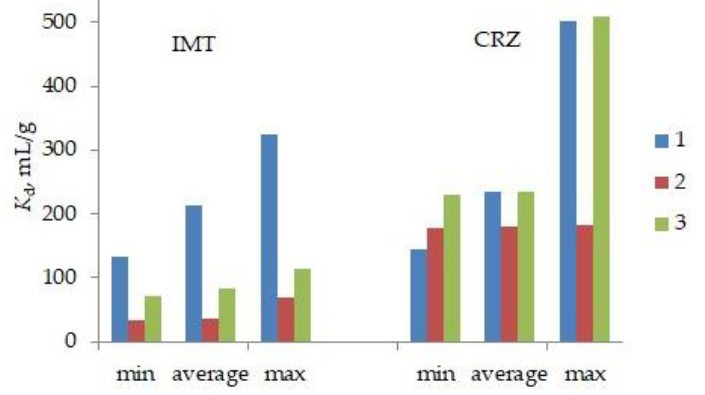
Figure 4. Effect of sorbent dosage (1 — suspended TiO 2 , 2 — TiO 2 -GF, 3 — TiO 2 /CNT-GF . 1: min — 0.5 g/L, average — 1.0 g/L, max — 1.5 g/L; mass layer of 2: min — 2.3 g/L, average — 3.7 g/L, max — 5.2 g/L; mass layer of 3: min — 47.8 g/L, average — 73.2 g/L, max — 107.6 g/L).